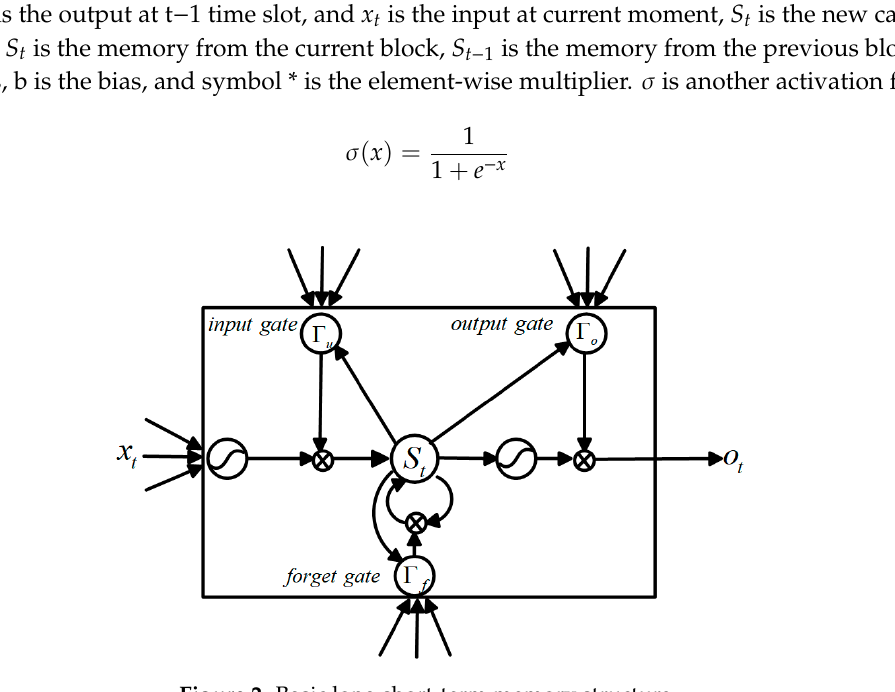
Figure 2. Basic long short-term memory structure.